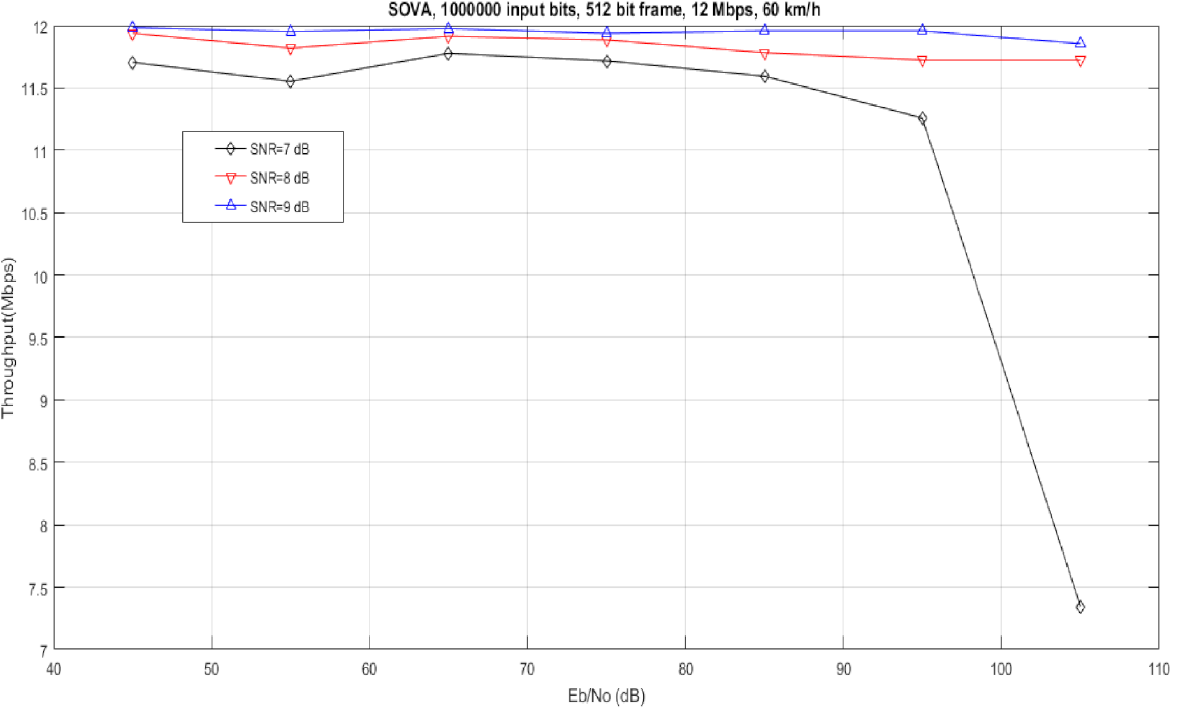
Figure 8. Throughput vs. Vehicle density for GEMV channel, 3 different SNR values, 12 Mbps data rate, 60 km/h mobile terminal speed, SOVA algorithm, 3 iterations, frame length of 512